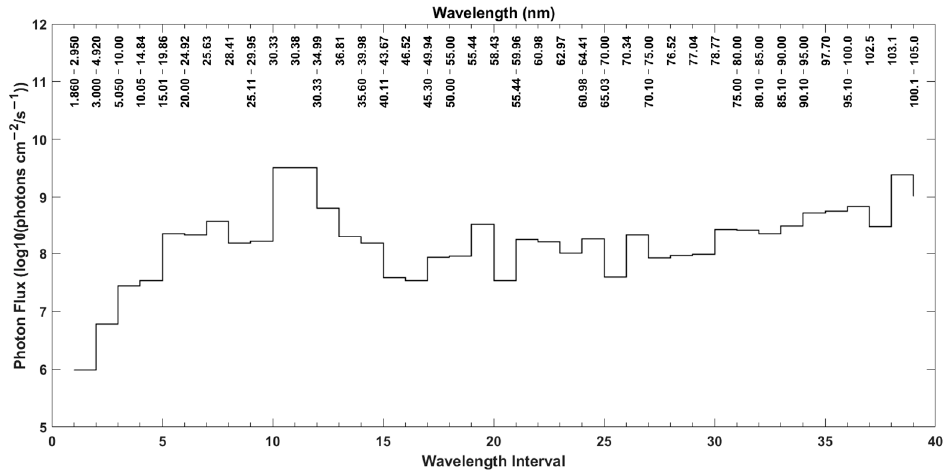
Figure 1. Solar irradiance values (log10(photons cm − 2 /s − 1 )) from different wavelength bins used in this model.